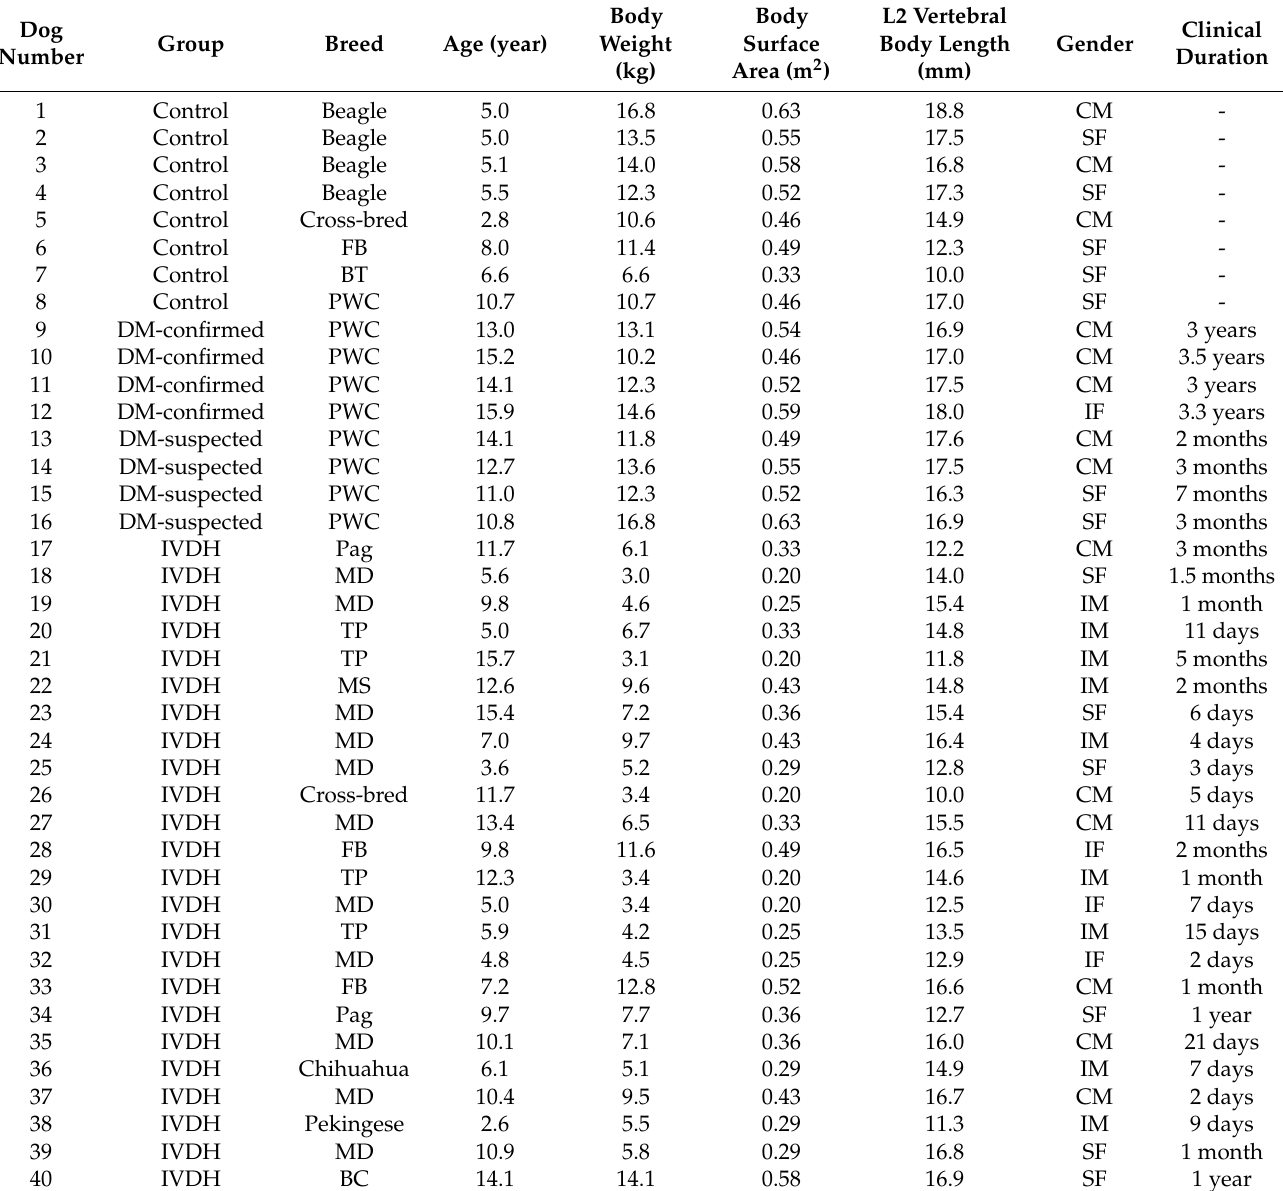
Table 1. Characteristics of clinical samples 1